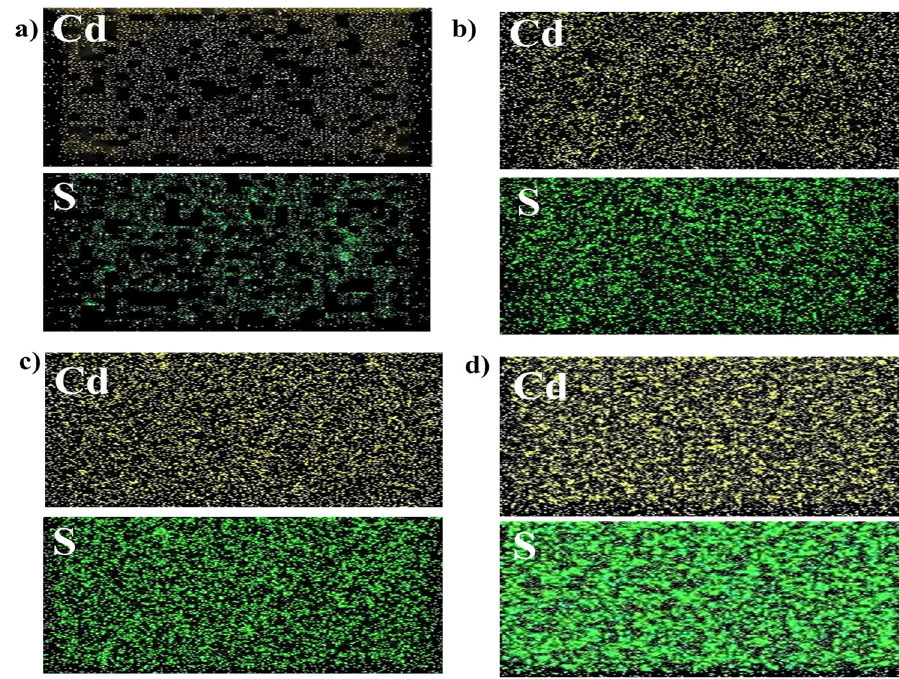
Figure 8. EDX elemental mapping of CdS thin film for different (Cd/S) ratio as (a) [1/0.75], (b) [1/1], (c) [1/5], (d) [1/25]. ( c ) [1/5], ( d ) [1/25].